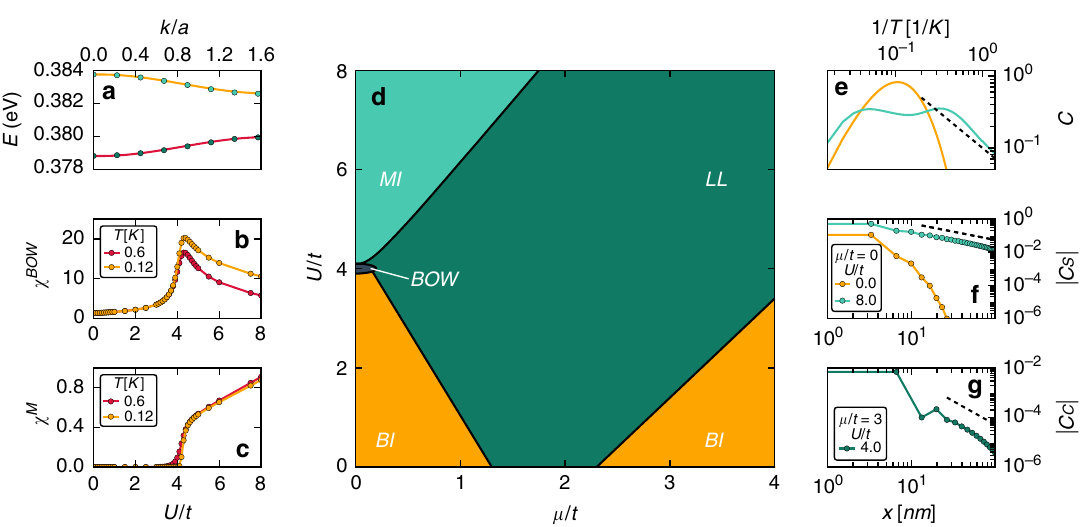
Fig. 2 Characterization of many-body electron correlations in twisted bilayer GeSe. a Fit (solid lines) to the ab initio results shown in Fig. 1. The fi t yields parameters t ¼ 1 : 03 meV and ϵ 0 = t ¼ 1 : 3 for ϕ ¼ 6 : 61 (cid:1) . b , c Susceptibilities for bond order, as well as magnetization are used to map out the phase boundaries between the Band insulator (BI), the bond ordered wave (BOW) state and the Mott insulating (MI) state at half fi lling μ ¼ 0. The fi rst transition (BI ! BOW) is a continuous Ising phase transition, while the second (BOW ! MI) is of the Kosterlitz-Thouless type 34 – 38 . Upon doping the system away from half fi lling the system turns to a gapless Luttinger liquid state (at non-zero U ) characterized by critical power-law correlations in spin and charge degrees of freedom. The full phase diagram at T ¼ 0 is summarized in d . e Speci fi c heat and ( f ) spin-spin correlation function at half fi lling for two values of U , placing the system either in the band insulating or Mott insulating state, respectively. The speci fi c heat ( e ) at large inverse temperatures 1 = T turns from exponential (BI) to linear (MI) which is a hallmark of gapless spin excitations in the MI state. The double maxima structure in c is a hallmark of the lower and upper Hubbard band 57 . We fi nd that at 1 K the system starts to show clear MI behavior (speci fi c heat c turns linear) for U = t ¼ 8. Panel f shows the spin-spin correlation function. In the BI phase we fi nd exponential suppression, while in the MI state the state shows long range algebraic correlations C (cid:5) x (cid:3) 1 at T ¼ 1 = 8 K . Panel g shows the charge-charge correlation function obtained for fi nite doping μ = t ¼ 3. The long-ranged power-law decay (dashed S line) in the correlation functions falls of as approximately C S (cid:5) x (cid:3) 1 : 9 which is indicative of a weakly correlated Luttinger liquid (Luttinger parameter K ¼ 0 : 95) at this U = t ¼ 4. C